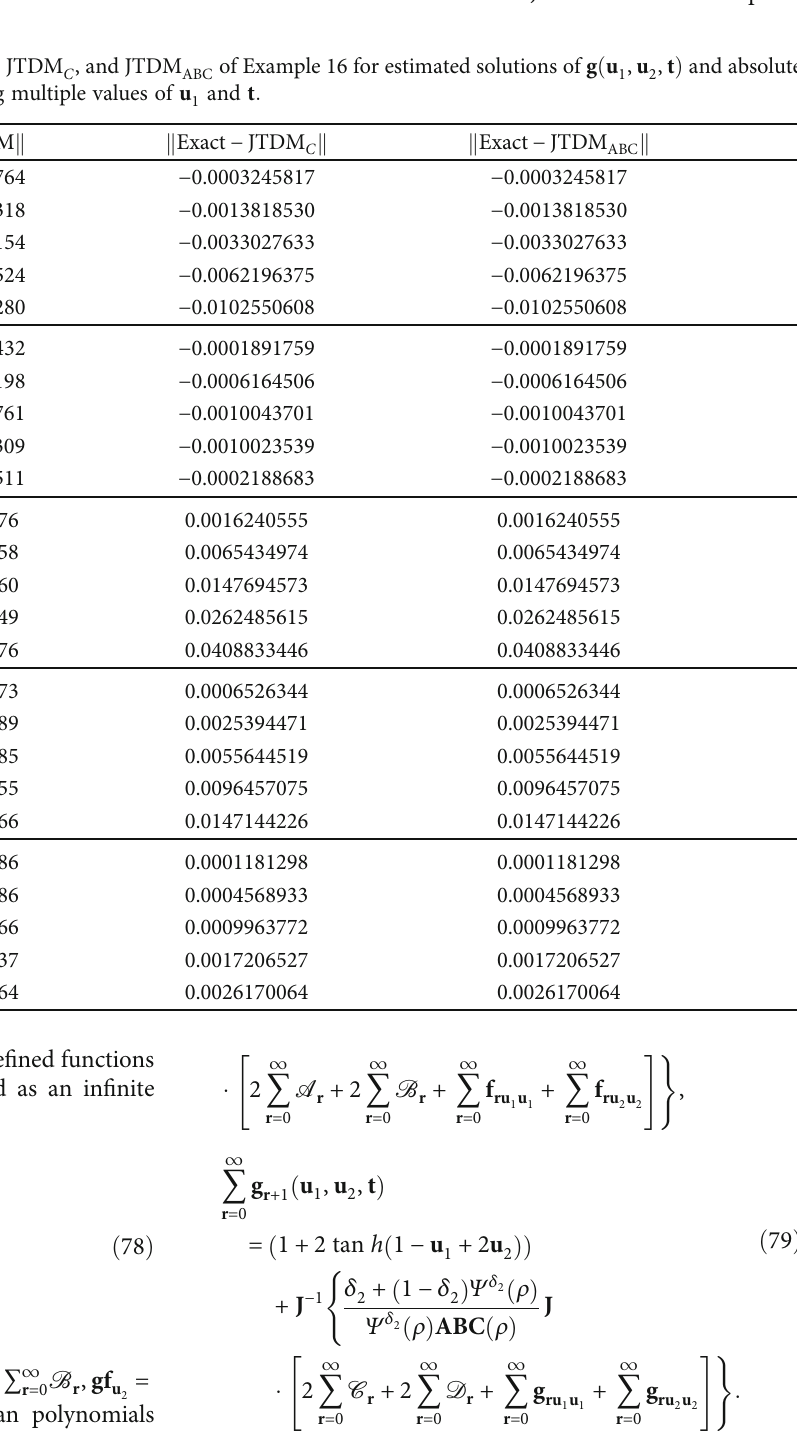
, u , t Þ and absolute 2